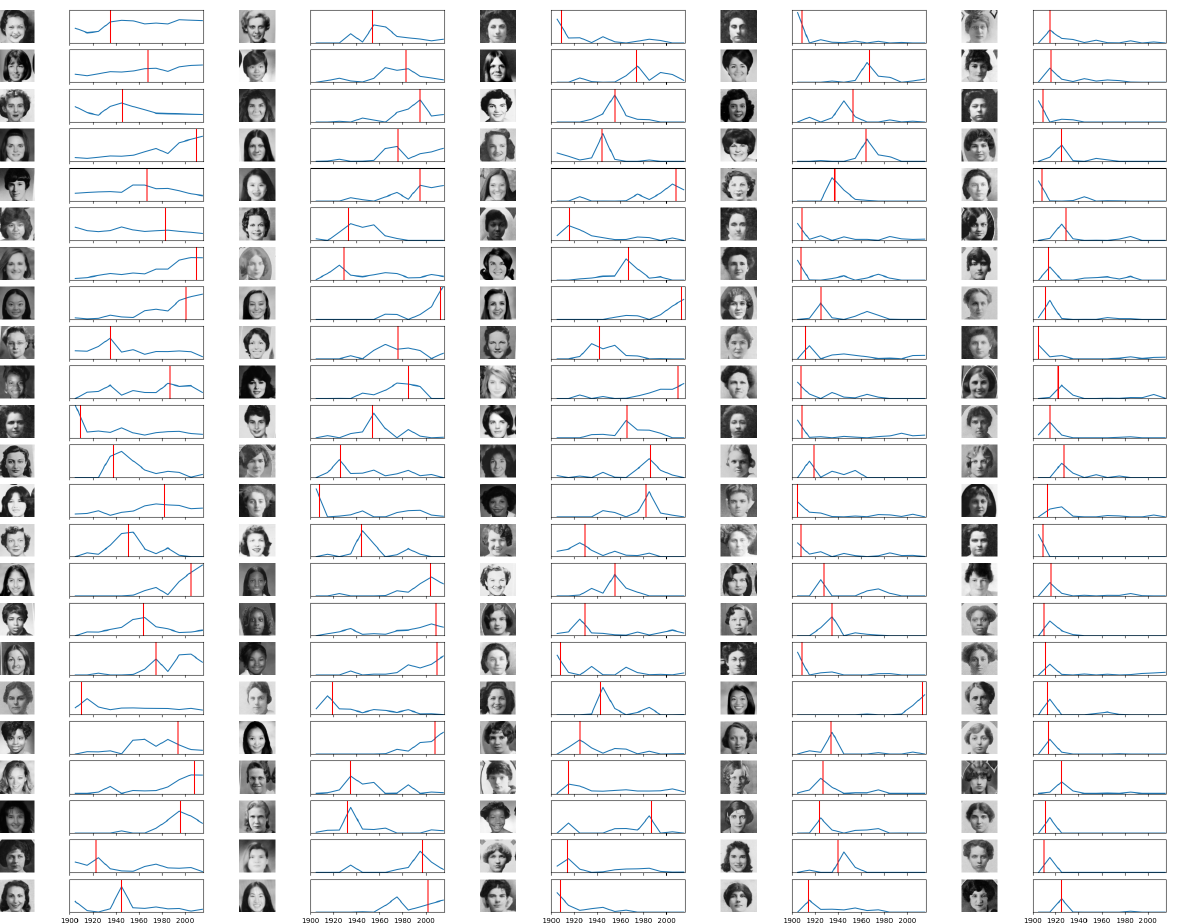
Figure 10. Visualization of an 0.1-MMD dependent coreset for 12 datasets, each containing yearbook photos from a given decades. Photos show the exemplars { u i : i ∈ S } , ordered by their average weight across the 12 marginal coresets. To the left of each photo is a plot of the corresponding weight over time; a red vertical line marks the year the photo was